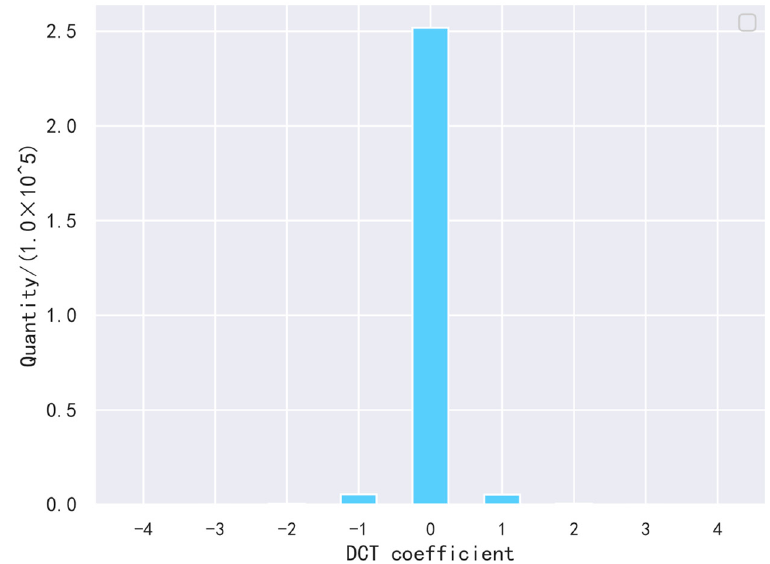
Figure 4. Distribution of DCT coefficient values.